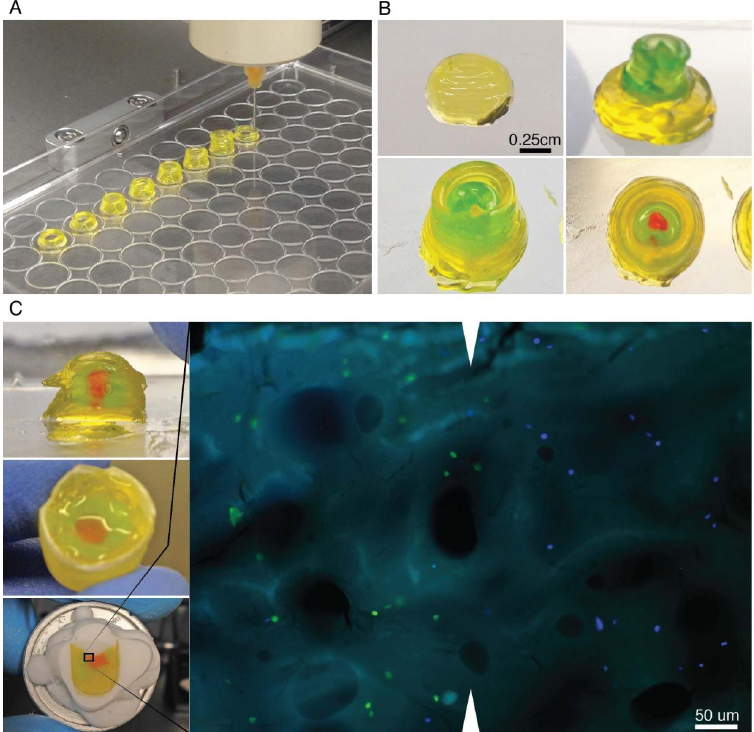
Figure 5. 3D-Printing of freeze-thawed G EYP and implementation of 3D-Cryo well insert for characterization of extruded structure. ( A ) Pneumatic bioprinter print head rapidly extruding cylinders of freeze thawed G EYP on the lid of a 96 well plate; ( B ) Various layers involved in printing CAD designed model to study interfaces (ball and socket); in this structure, no cells are involved; ( C ) 3D-printed ball and socket model sectioned in half with glass coverslip to show sagittal/coronal plane (top left). Manually extruded reproduction of ball and socket model in histology well insert loaded with various fluorescent labelled cells (centre left). 3D-Cryo well insert mounted on cryotome cutting block sectioned to the core (bottom left). Examination of the resulting sagittal/coronal section from the 3D-Cryo well insert mounted on a glass slide and imaged with fluorescence light (Right). Cells are seen in green and blue distributed in the biomaterial. As they were extruded in separate inks, they are also separated in the images. White triangles show the interface